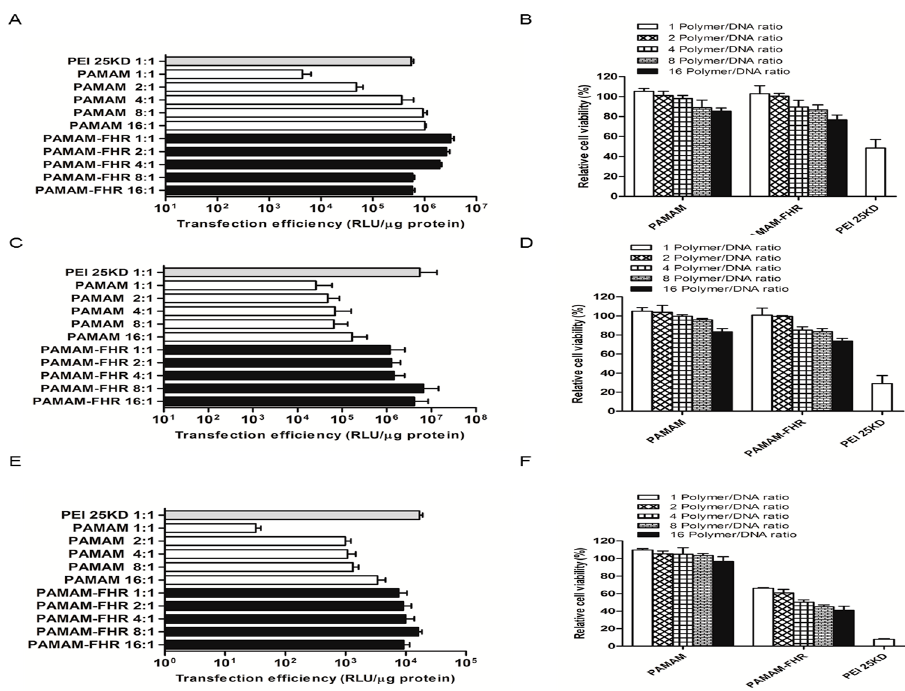
Figure 3. Luciferase activity of PAMAM-FHR. ( A ) GBL-14, ( C ) U373-MG, and ( E ) dermal fibroblasts were treated with each polymer/DNA complex at different weight ratios ranging from 1 to 16. ( B ) GBL-14, ( D ) U373-MG, and ( F ) dermal fibroblasts were incubated with same conditions as those used for luciferase activity assay. The cytotoxicity of complexes was assessed. Results are shown as the mean ± standard deviation, n = 3.